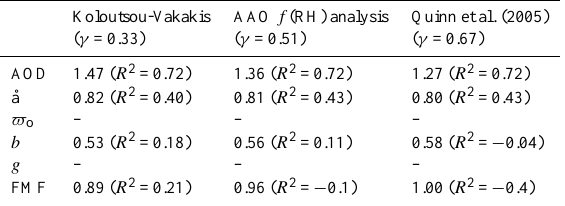
Table 3. Slopes of the linear regressions forced through zero for the comparison between AERONET and AAO using different hy- groscopicity parameterizations.